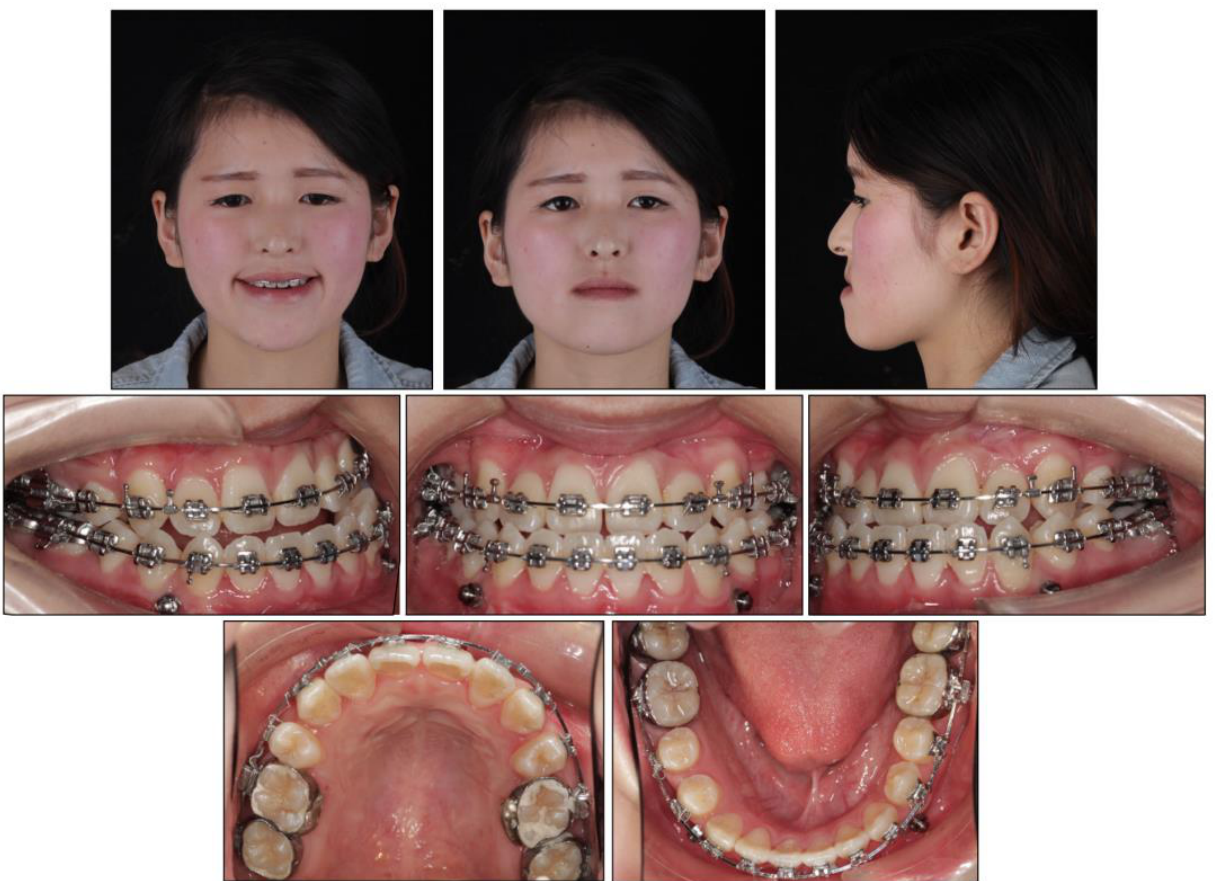
Figure 5. Subepithelial connective tissue transplantation.